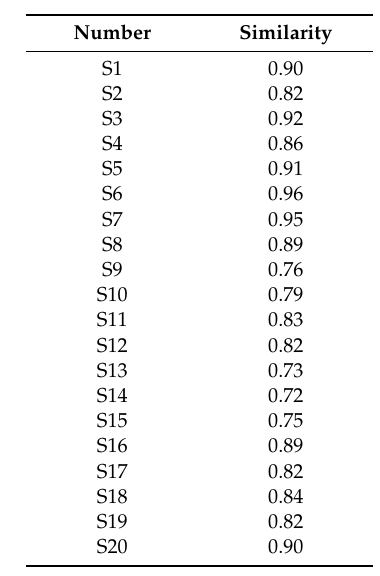
Table 6. Similarity of Psorslea corylifolia L.